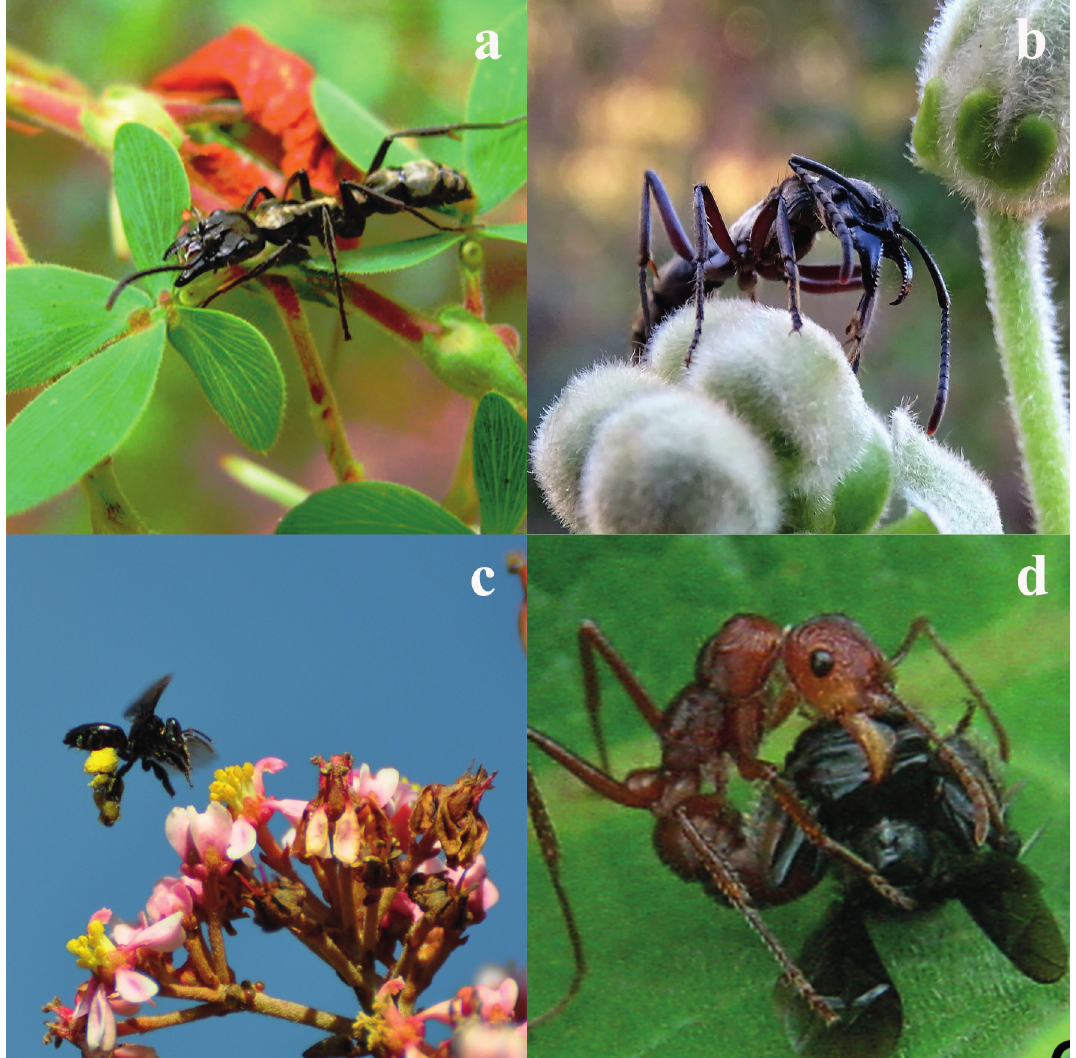
Figure 2 - Ants feed on different plant resources and extrafloral nectar (EFN) is the most common. Plant produces this secretion rich in water, sugar (fructose and sucrose), amino acids, and other substances in small quantities that attract ants that climb onto the plants and protected them against natural enemies, like herbivores ( a – Neoponera villosa feeding on eFN in Inga vera , Leguminosae). This relationship is named mutualism, where both organisms benefit each other. However, these ants also need protein (the reason they protect the plants) and walk by all plant parts searching for animal food, including the inflorescences ( b ). But, plants need pollination to reproduce, what is related to other visitors like bees ( c – Trigiona sp). When ants casually find pollinators, they represent food, and the ants will attack then ( d – Ectatomma tuberculatum preying on a Trigona asp), now prejudicing the plant reproduction. It represents an unexpected effect of a mutual